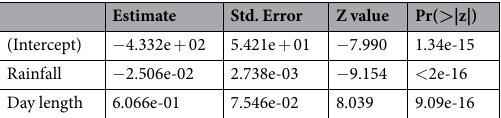
Table 1. GLM output for the fixed effects of the probability of dawn-song over seasons. There are higher probabilities of dawn-song occurring when associated with increasing in day